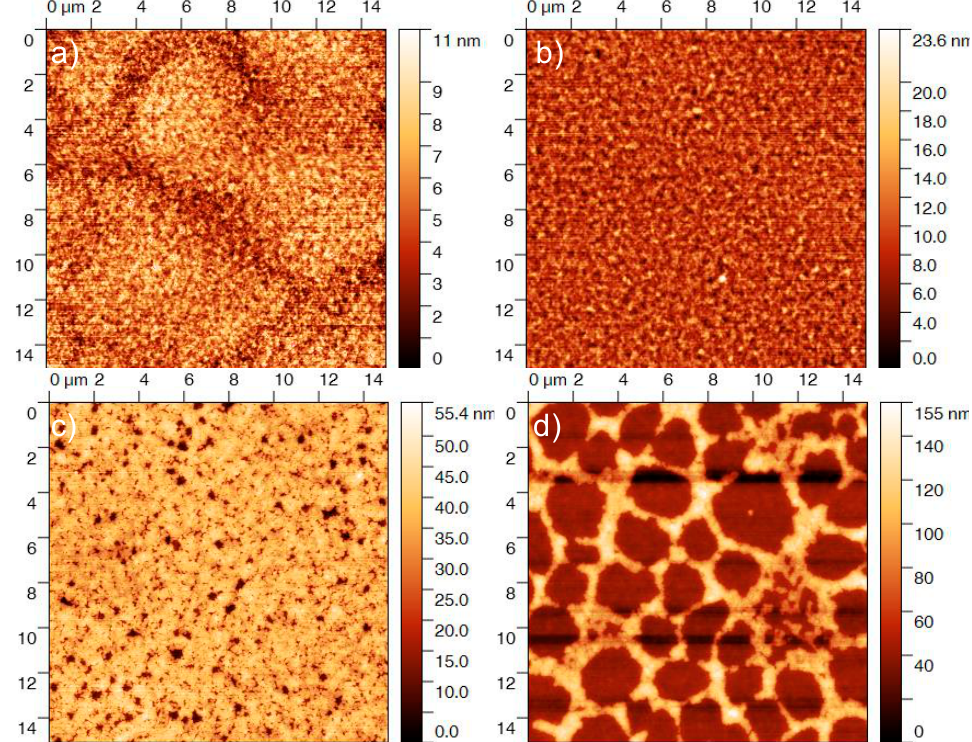
Figure 5. Topography of free surfaces of PC 60 BM/P3HT bilayer exposed to chloroform vapor for various periods of time: ( a ) as-prepared, ( b ) 30 min, ( c ) 45 min, and ( d ) 60 min.